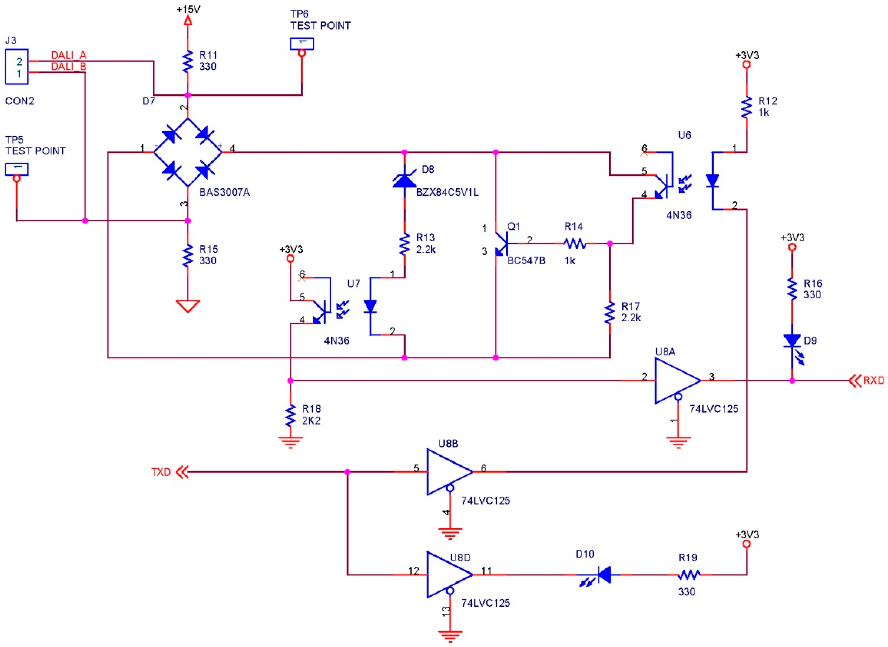
Figure 13. DALI interface. Figure 13. DALI